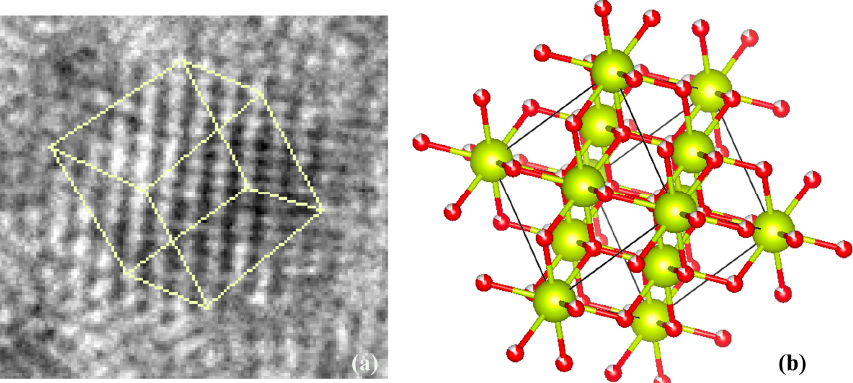
Figure 10. Schematics diagrams of ( a ) FCC structure of CeO 1.66 and ( b ) schematics lattice structure of CeO 1.66 .